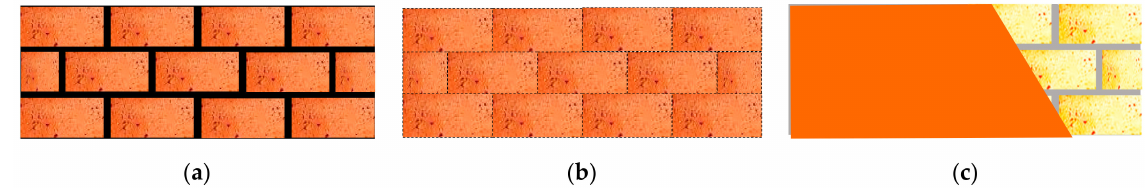
Figure 6. Finite element modeling approaches: ( a ) detailed micro-model, ( b ) simplified micro-model, ( c ) macro-model.